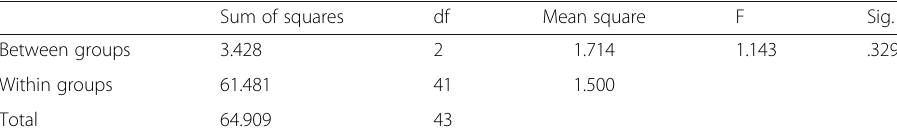
Table 1 One- way ANOVA on the groups ’ performance on the UGJT as pre-test Sum of squares df Mean square F Sig. Between groups 3.428 2 1.714 1.143 .329 Within groups 61.481 41 1.500